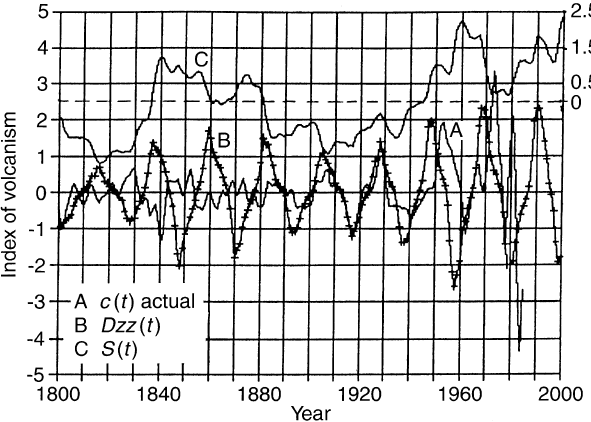
Fig. 17. Volcanism and ‘‘groomed’’ solar